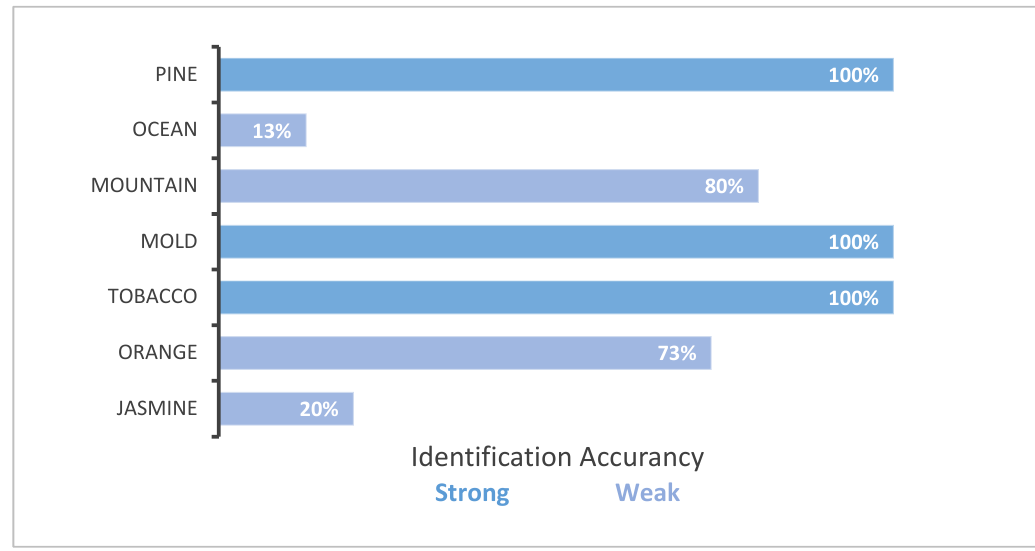
Figure 9. Percentage of users identifying the release of a scent.